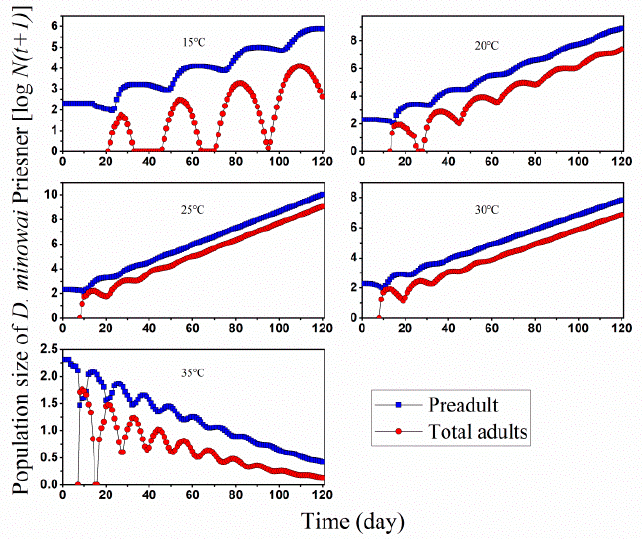
Figure 6. Simulation of D. minowai population size starting from 200 eggs at different constant temperatures.